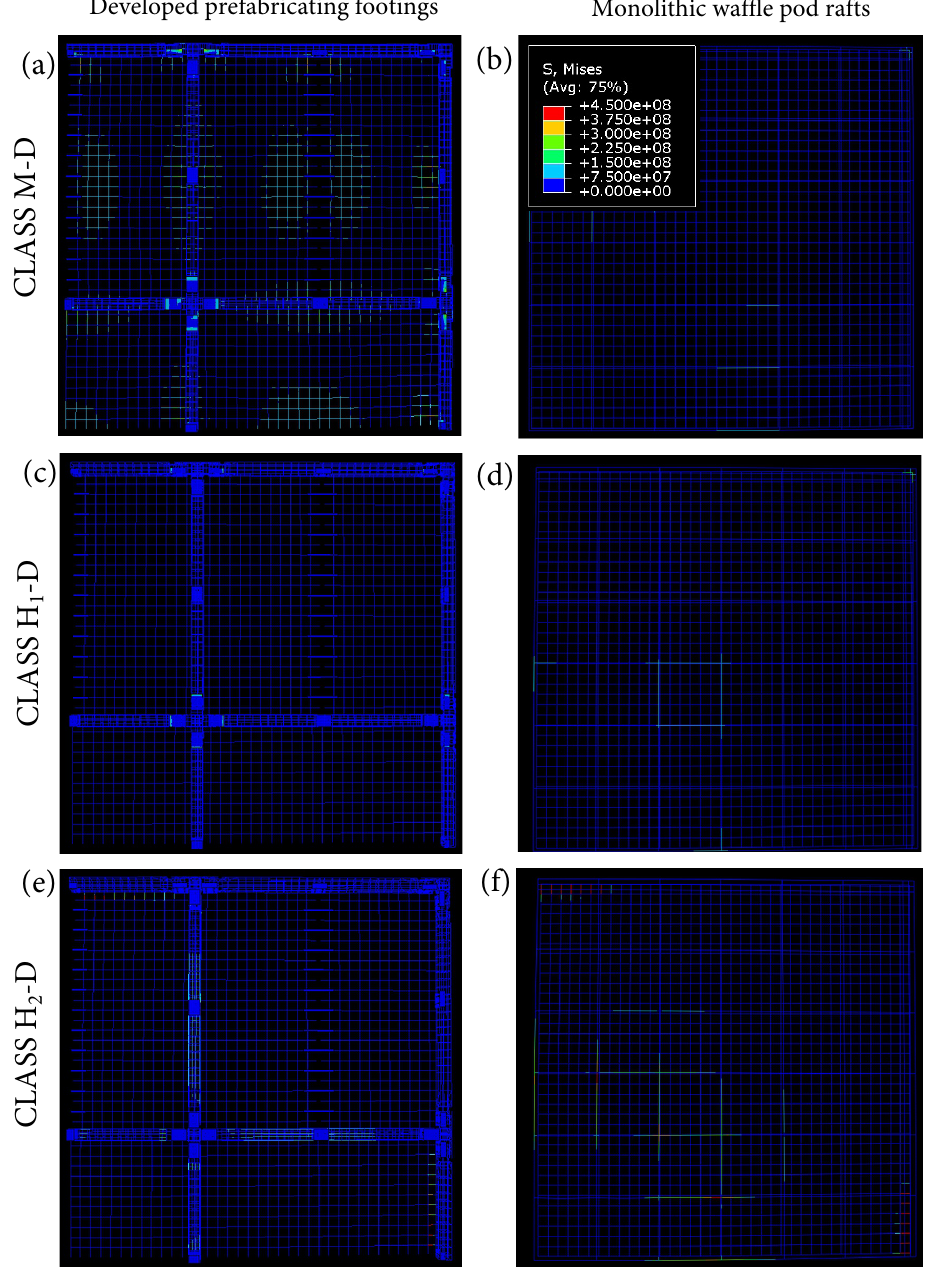
Figure A4. Comparison of steel stress in footing systems due to swelling soil and applied loads between the developed prefabricated footing systems and waffle rafts for ( a , b ) Class M-D soil, ( c , d ) Class H 1 -D soil, and ( e , f ) Class H 2 -D soil. Values of stress are in